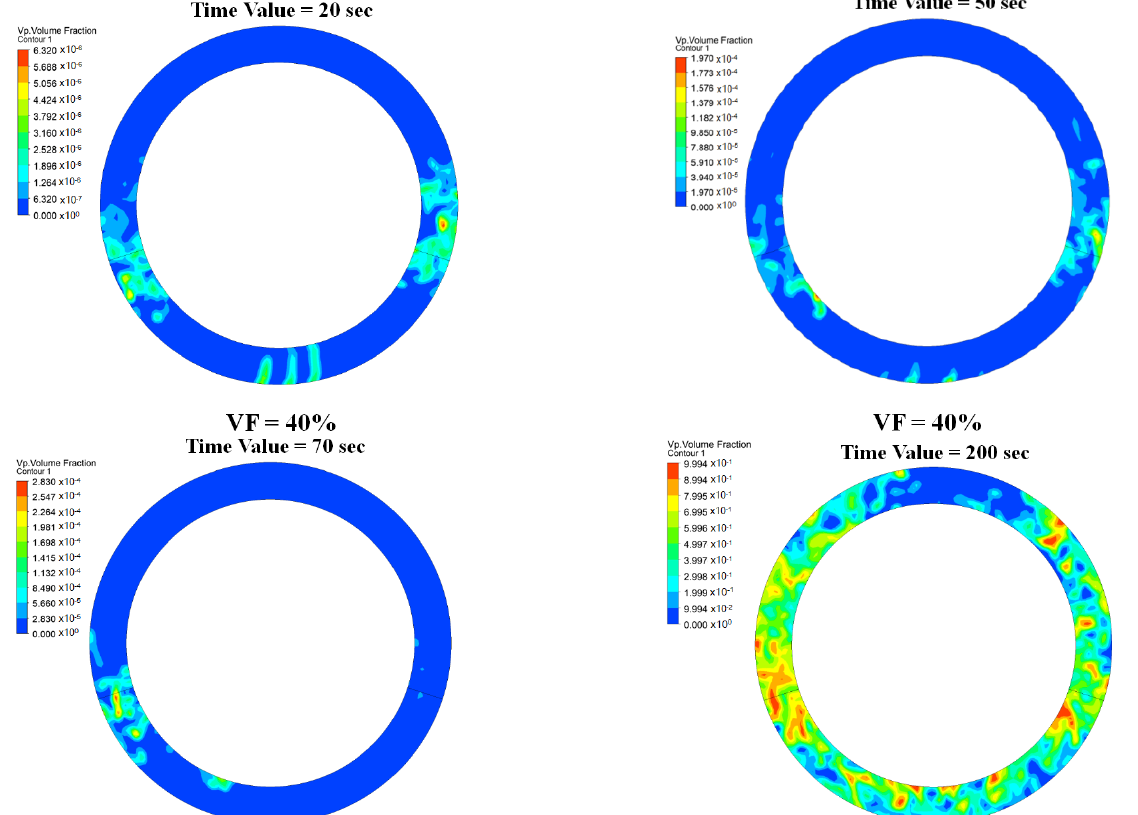
Figure 11. Transient vapor volume fraction contour with different charged amounts.